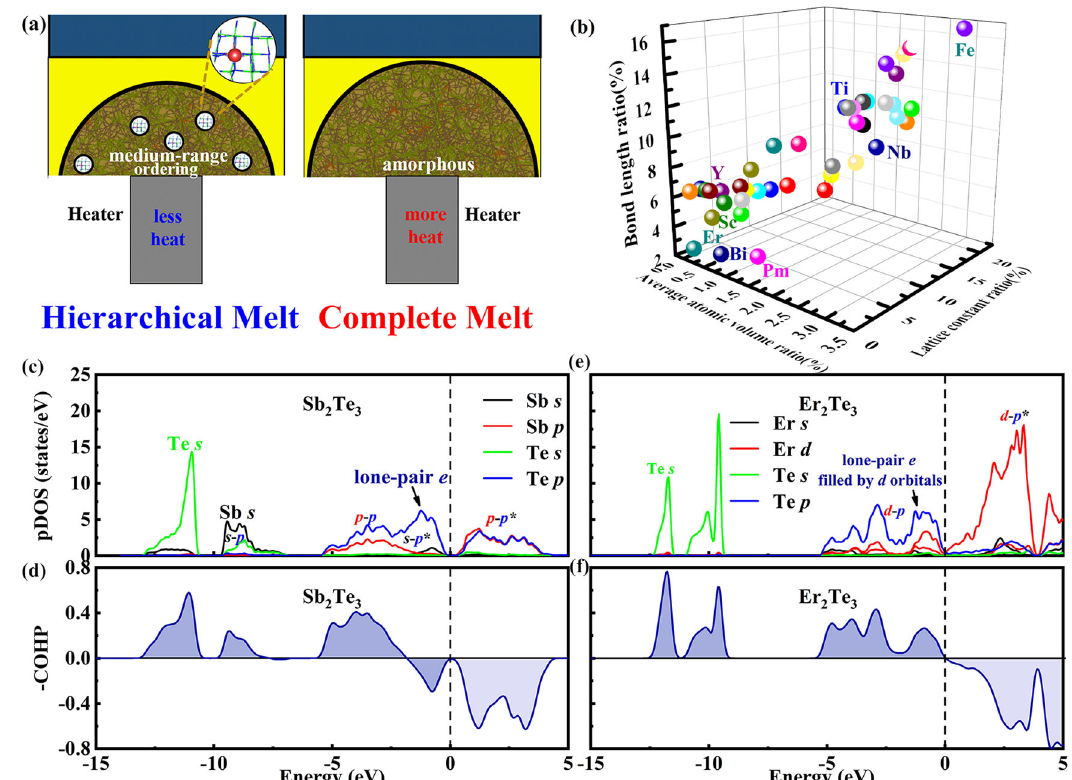
Fig. 1 Alloy design. a The schematic diagrams of device cells with different amorphous states as different power is provided. The left part has many medium-range ordering regions as less heat is provided, while the right part is a fully disordered amorphous state as more heat is provided. b , The lattice mismatch between metal tellurides and Sb 2 Te 3 , where Er has the least mismatch. c – f Evidences of orbital interactions by calculating the pDOSs and COHP of Sb 2 Te 3 and Er 2 Te 3 . c , e The pDOSs for various orbitals. d, f The -COHP curves for Sb 2 Te 3 , and Er 2 Te 3 , respectively.